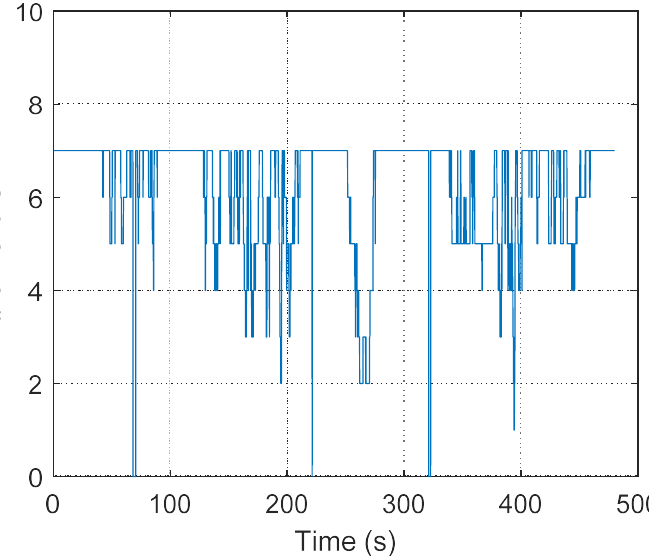
Figure 12. Number of valid satellites for the time-differenced carrier phase (TDCP)-based vehicular heading and pitch angle estimation.